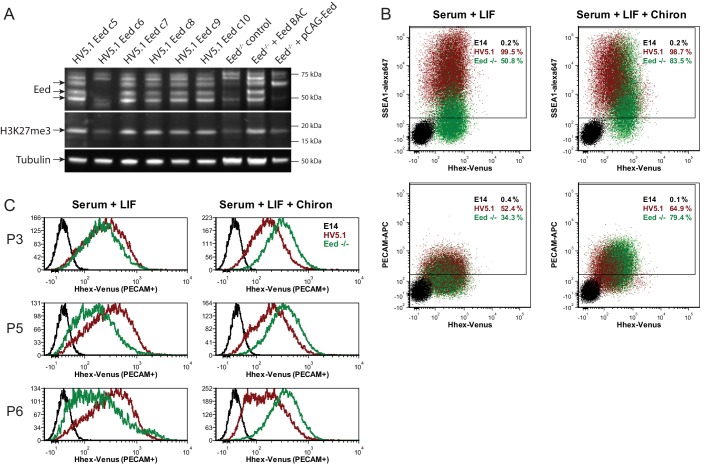
Eed deficient ESCs cannot maintain Hhex priming in self-renewal.(A) Western blot for EED, H3K27me3 and Tubulin showing Eed mutation in HV5.1 Eed clone 6 induced by CRISPR. A homozygous mutant clone is shown alongside several transfected clones that were either WT or heterozygous. The absence of Eed protein in the mutant clone is apparent and consistent with the observed loss of H3K27me3, indicating that Eed has been knocked out. (B) Flow cytometry of HV5.1 parental and Eed-/- HV5.1 c6 cells stained with either SSEA1-alexa647 or PECAM-APC. Eed-/- HV5.1 cells did not proliferate well in serum + LIF and required the addition of the Gsk3 inhibitor Chiron to support efficient expansion. After three passages, Chiron could be removed without a clear effect on proliferation. Under these conditions, Eed-/- HV5.1 cells exhibited a loss of Hhex heterogeneity in standard culture, but there was a marked stimulation of Hhex expression to levels not normally observed with the HV reporter, when they were cultured in Chiron. SSEA1 and PECAM profiles of Eed-/- HV5.1 c6 cells in either serum + LIF (2 passages after Chiron removal) or serum + LIF + Chiron (2 passages) are shown. (C) Eed-/- HV5.1 c6 cells in either serum + LIF or serum + LIF + Chiron can be shifted between media states and re-establish heterogeneity or loss thereof, based on the culture media. P3, P5 and P6 to the left of the histograms are passage numbers in the indicated media.